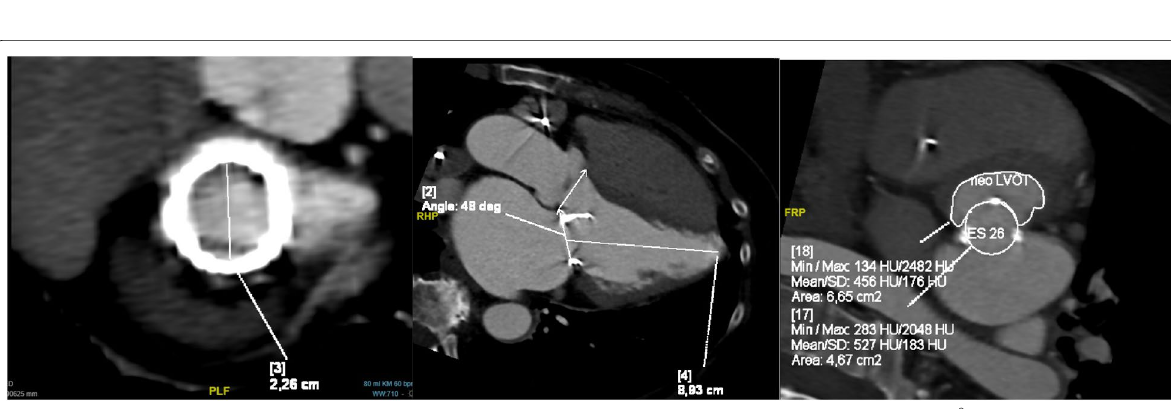
Fig. 3 CT assessment of (1) internal diameter of the prosthesis, (2) aortomitral angel of 132°, (3) neo LVOT area of 6.6 cm 2 . LVOT: left ventricular out flow